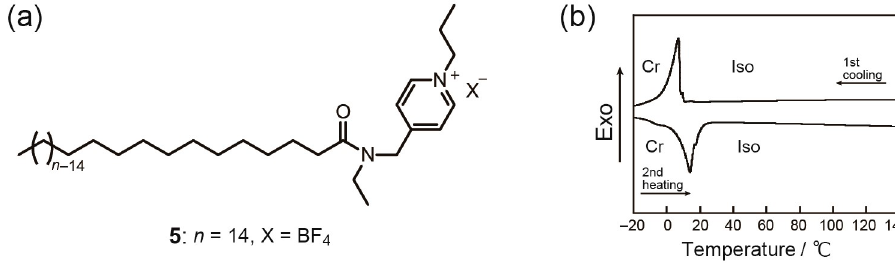
Figure 3. ( a ) Molecular structure of single-type compound 5. ( b ) DSC thermograms of 5.